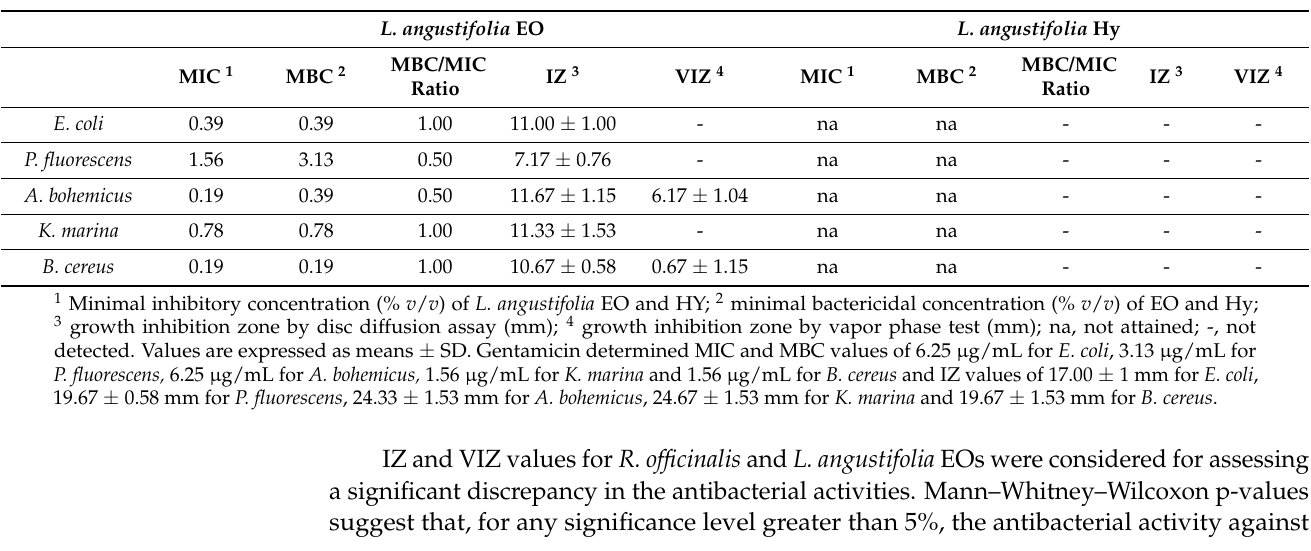
Table 6. Antibacterial activity of L. angustifolia EO and